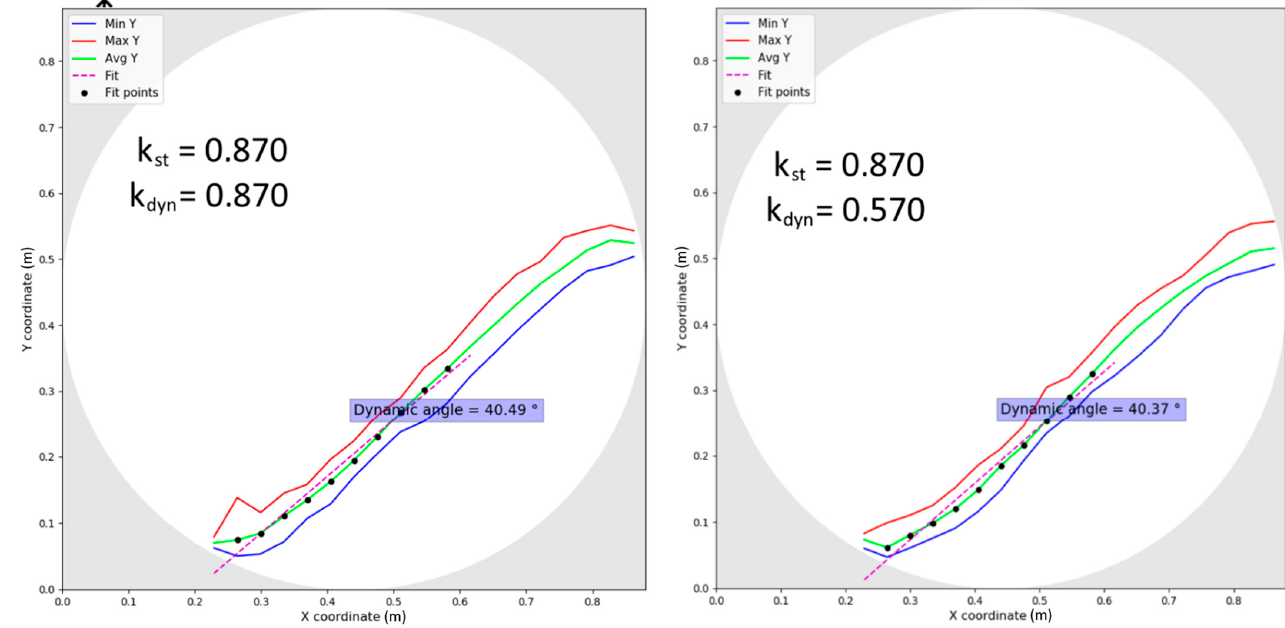
Figure 6. Two images from a series of numerical experiments to determine the influence of the dynamic friction coefficient between ore particles on the overall dynamics of the material in the rotating drum.